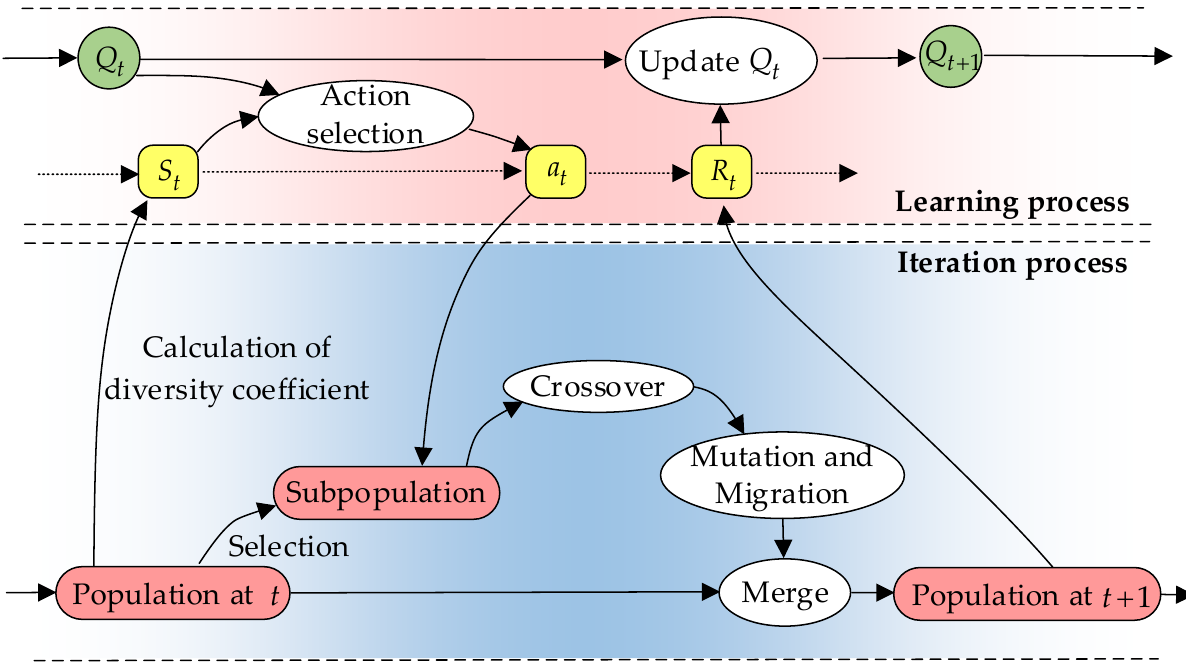
Figure 7. Warehouse layout of the robotic mobile fulfillment system.